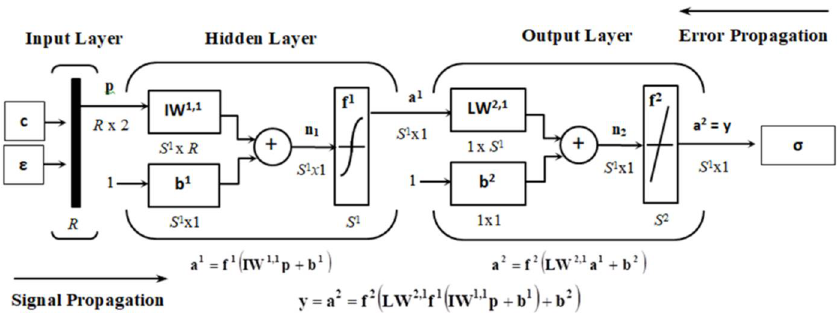
Figure 1. The scheme of multilayer feed-forward back-propagation artificial neural network for stress-strain curves prediction .